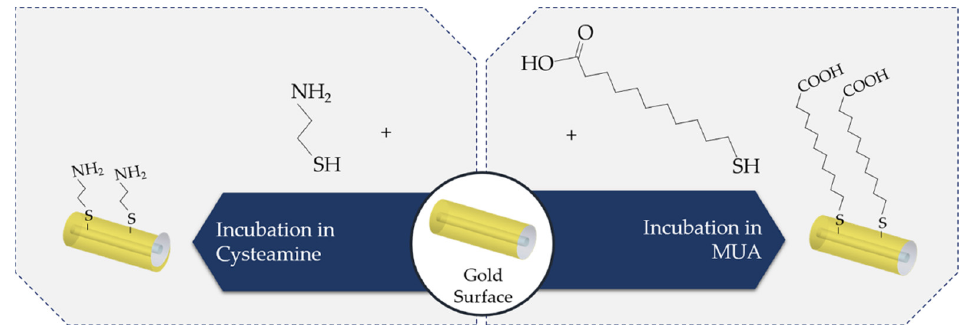
Figure 10. Schematic representation of a gold-coated fiber modified with cysteamine or MUA to produce amine-terminated or carboxylic-terminated surfaces, respectively.